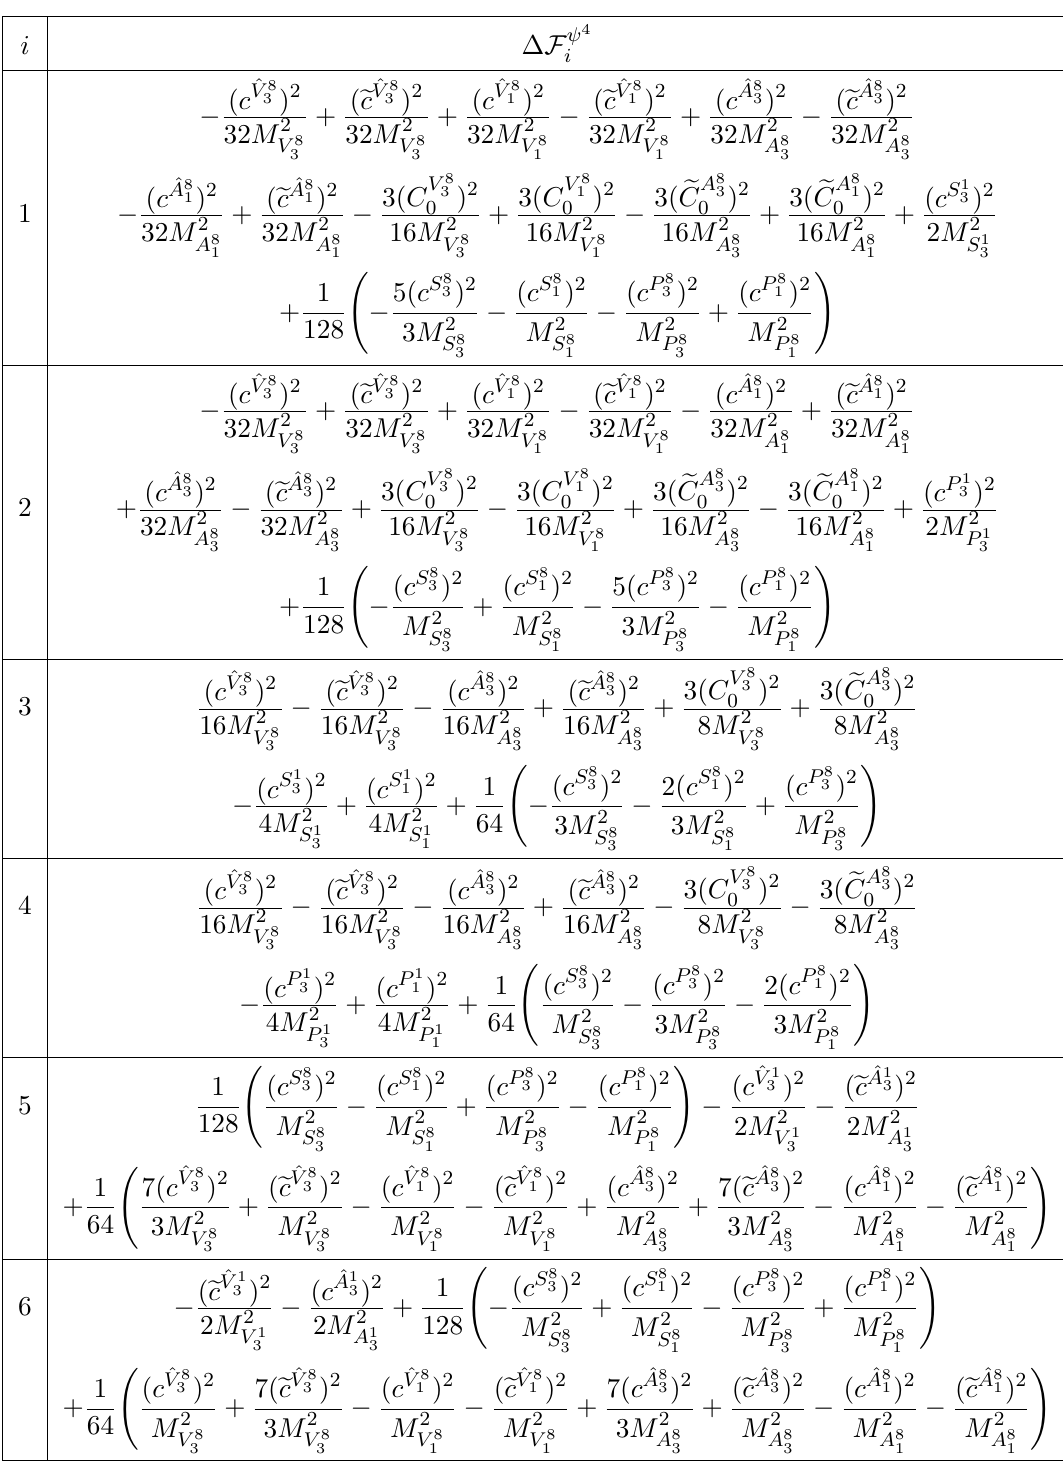
Table 5 . Contributions to the O ( p 4 ) LECs of four-fermion P -even operators from heavy scalar, pseudoscalar, vector and axial-vector